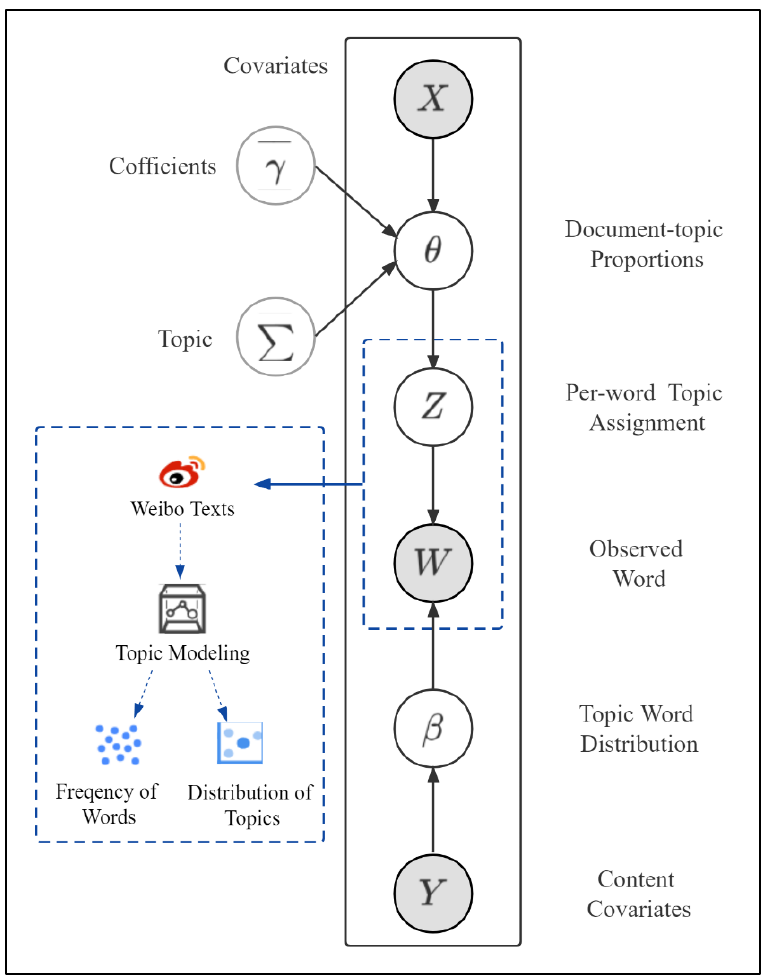
Figure 2. Plate diagram of structural topic model (STM).